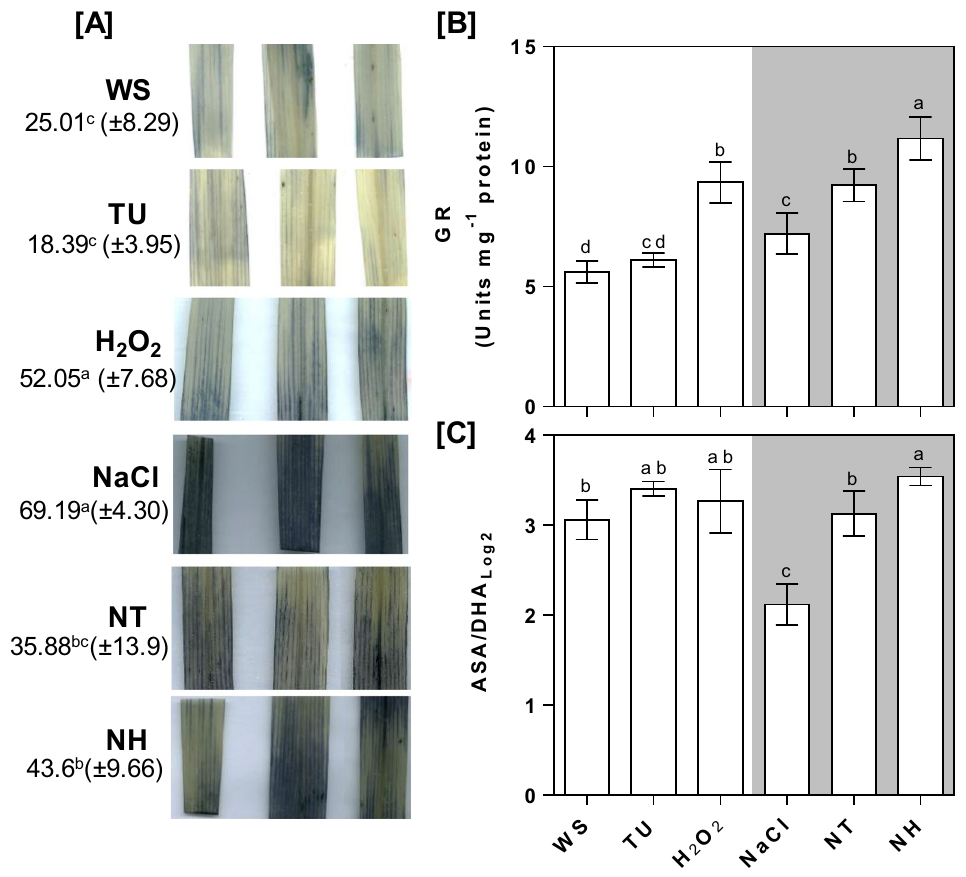
Figure 5. Measurement of the redox state in terms of the superoxide level, GR activity and ASA/DHA ratio. Pot-grown rice plants were given different treatments including WS (DW + 0.01% Tween-20), TU (6.5 mM TU + 0.01% Tween-20) and H 2 O 2 (10 mM H 2 O 2 + 0.01% Tween-20), NaCl (22 g NaCl per pot). NT and NH denote combined treatment of NaCl + TU and NaCl + H 2 O 2 treatments, respectively. A total of three foliar applications were given at vegetative, early anthesis and grain filling stages that corresponded to 40, 55 and 72 days post-transplantation, respectively. At 5th day after 3rd foliar spray, flag leaves were harvested for NBT based histochemical staining ( A ), quantification of GR activity ( B ) and ascorbate/dehydroascorbate (ASA/DHA) ratio ( C ). NBT stain intensity was quantified using image J software (version 1.53d; https ://image j.nih.gov) and represented as average arbitrary units (± S.D.). All the values are mean of triplicates ± SD. Different letters indicate significantly different values (DMRT, p ≤ 0.05 )